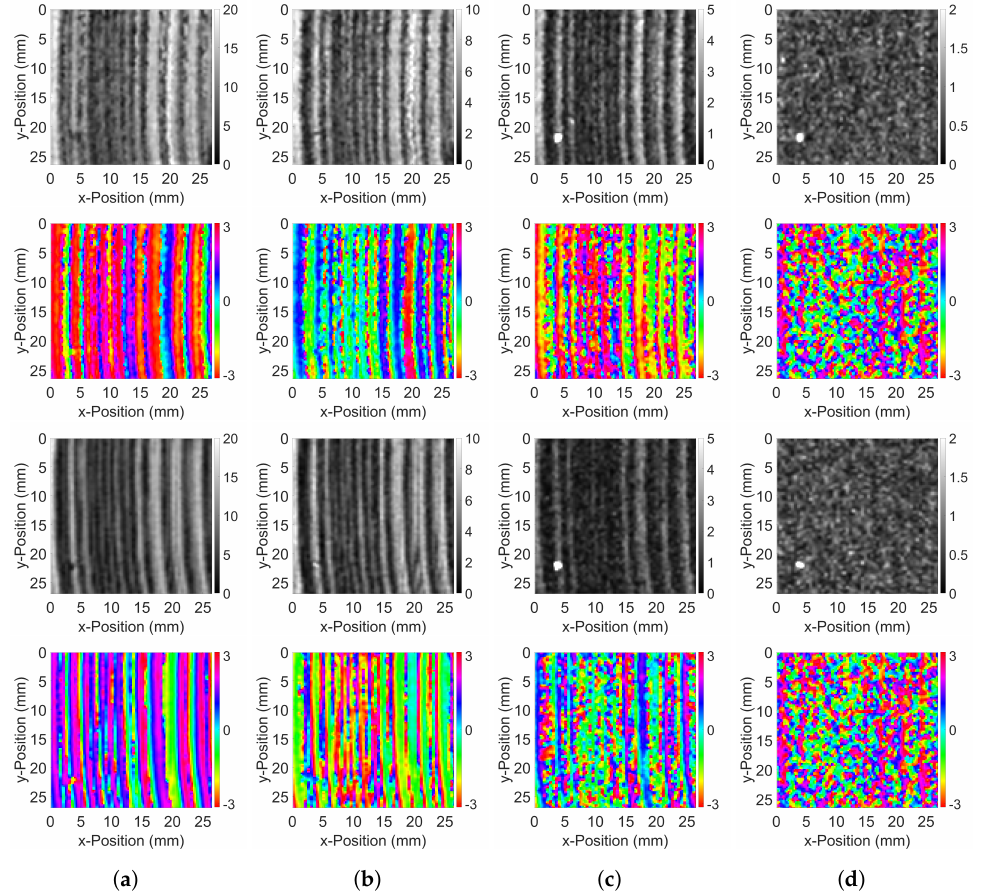
Figure 8. Intensity (gray scale) and phase images (color scale) of the wood sample #1. Sample orientation of annual rings with respect to polarization: α = 0 ◦ (top two rows) and α = 90 ◦ (bottom two rows): ( a ) 0.5 THz; ( b ) 1.0 THz; ( c ) 1.5 THz; ( d ) 2.0